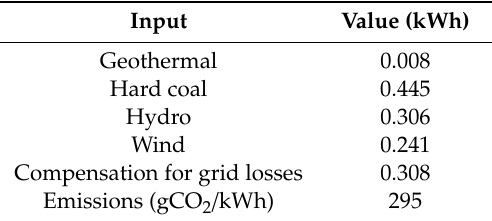
Table 3. Electricity mix for Portugal (2016), for the production of 1 kWh.